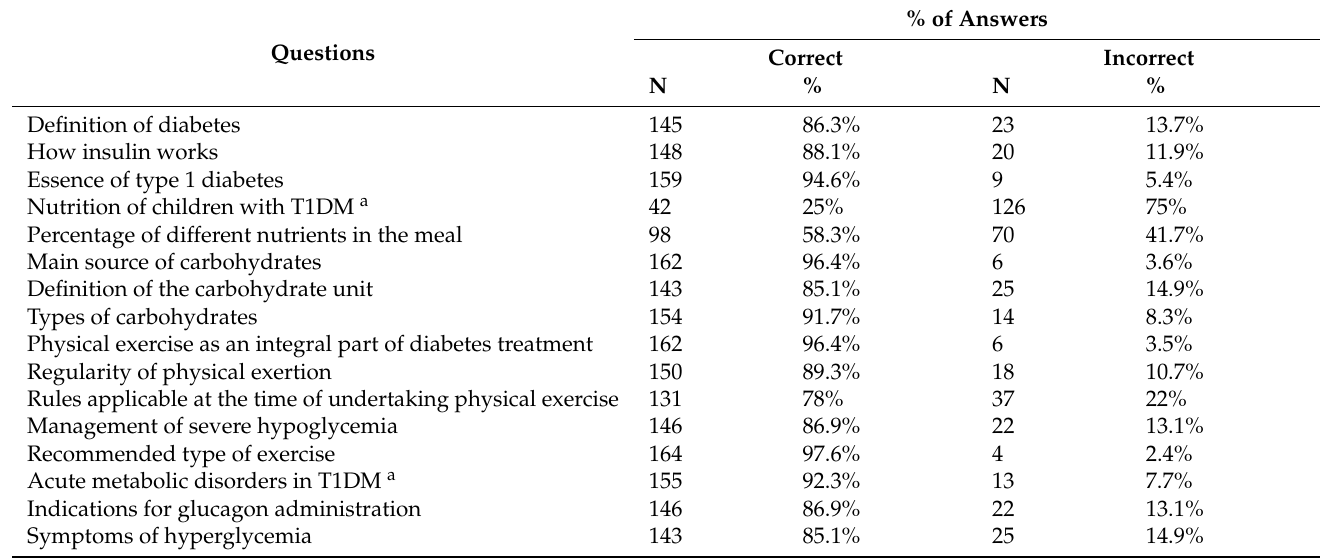
Table 2. Assessment of the knowledge of school nurses on the basis of a knowledge test (number and % of correct and incorrect answers).